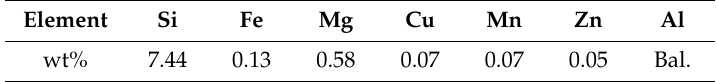
Figure 3. m ‐ SiCp characterization: ( a ) Scanning electron microscope (SEM) imaging detailing size and morphology; ( b ) size distribution of m ‐ SiCp. Table 1. Composition of the A356 alloy by optical emission spectrometry.